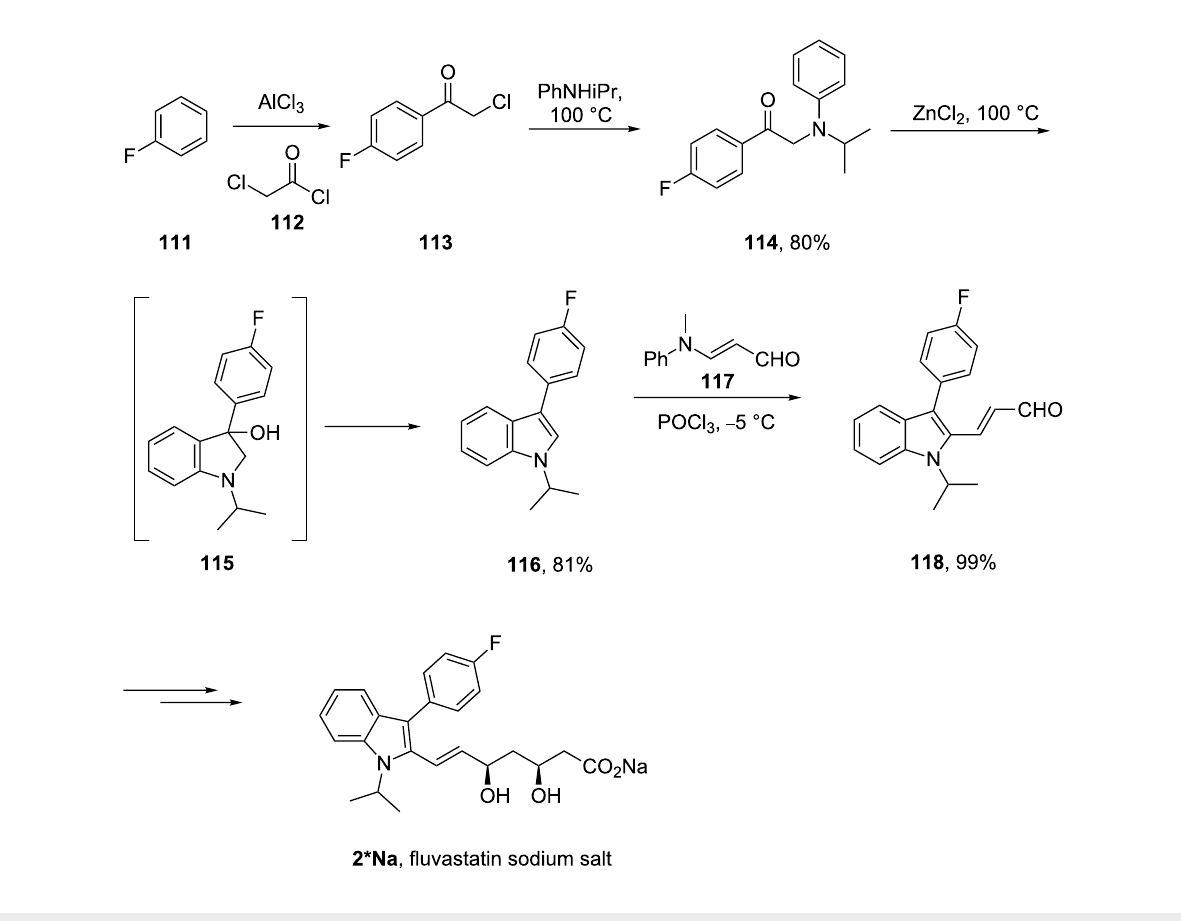
Scheme 25: Bischler-type indole synthesis used in the fluvastatin sodium